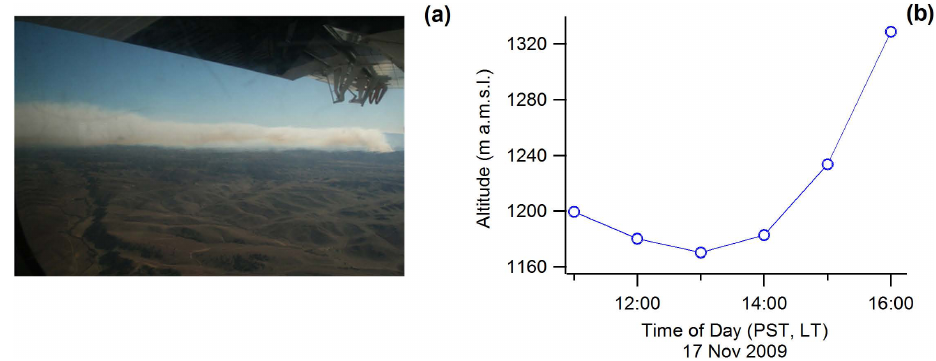
Fig. 2. (a) Side view of the Williams Fire high altitude plume at 12:40LT from ∼ 58km downwind. (b) HYSPLIT trajectory for source air starting at 11:00LT and 1200ma.m.s.l. No significant altitude gain is modeled in the first ∼ 4h since